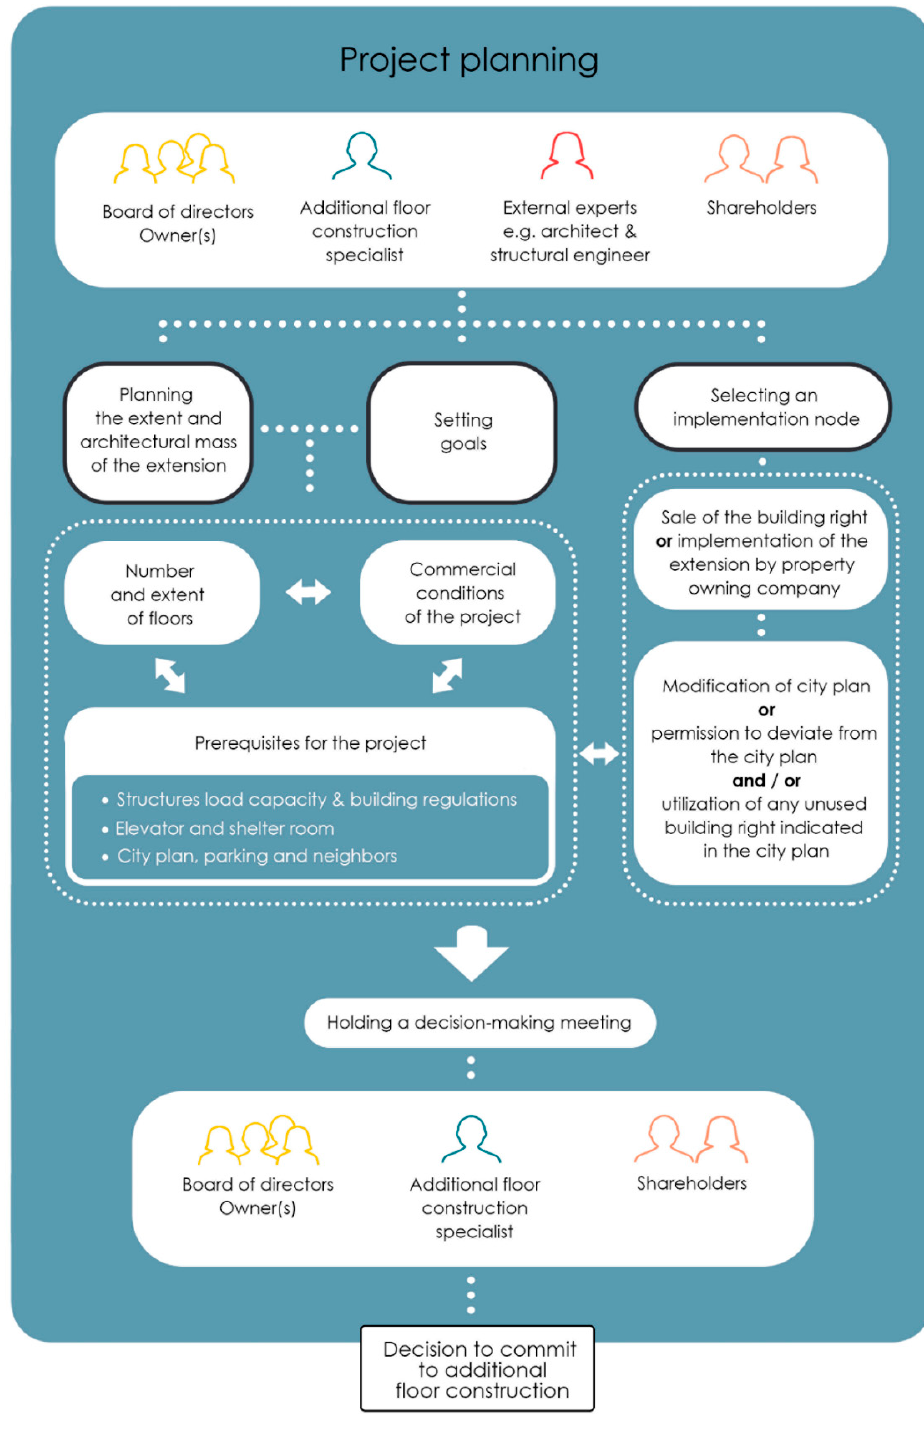
Figure 5. Project planning of additional